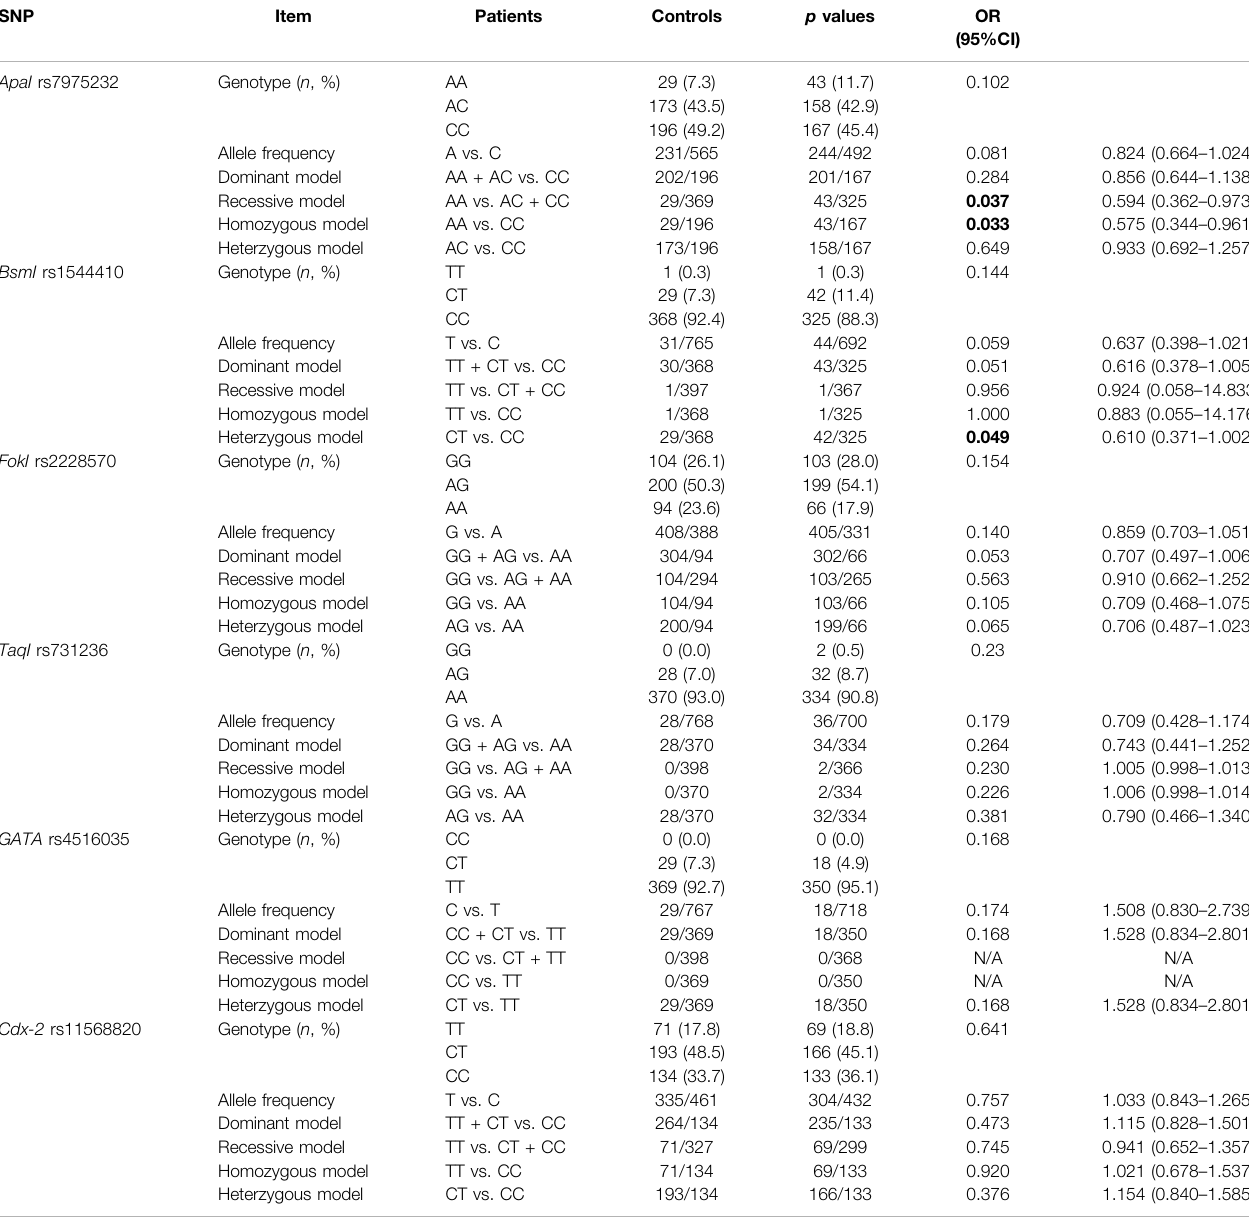
Bold values represent statistical signicance. OM, osteomyelitis; OR, odds ratio; CI, con fi dence interval; N/A, not